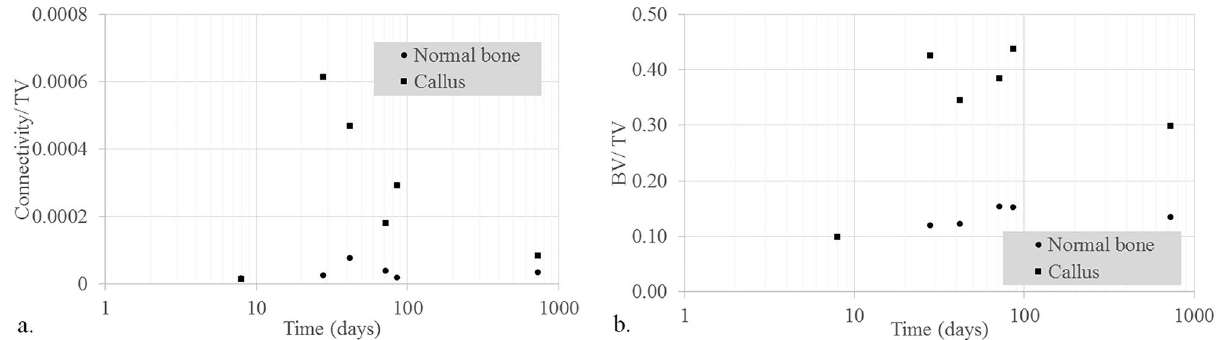
Figure 4. Connectivity density ( a ) and bone volume fraction ( b ), ( a ): ratio of the connectivity and total volume both in the callus and in areas distant from it; ( b ): bone volume fraction in the callus and in areas distant from it. Values for N2 were